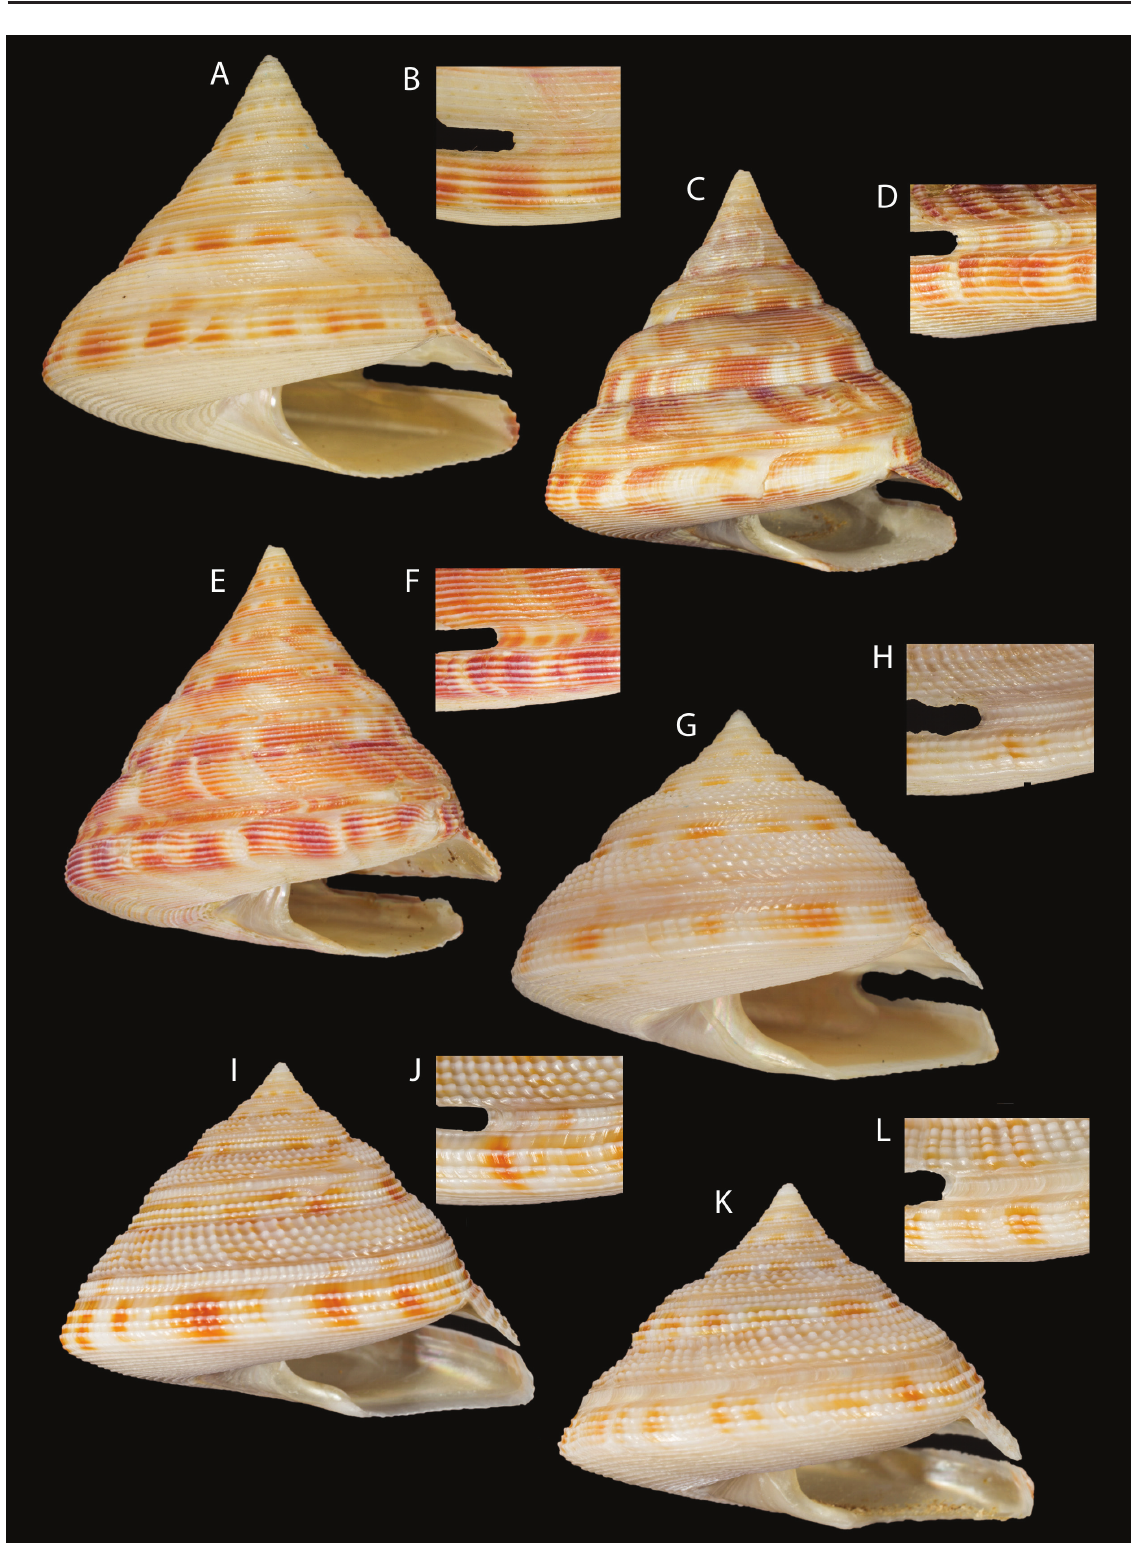
Fig. 7. A–F . Perotrochus caledonicus Bouchet & Métivier, 1982. A–B . Mnhn-iM-2000-1262,